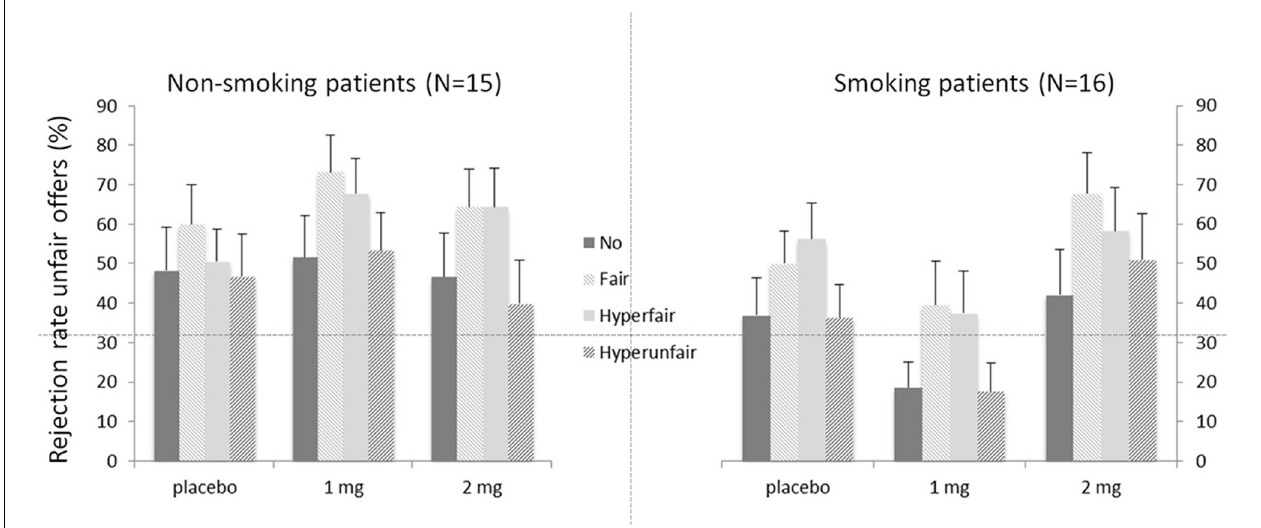
FIGURE 2 | Mean rejection rates in percentages for unfair offers depending on the alternative offers (context) for the two patient groups. Error bars represent standard errors of the